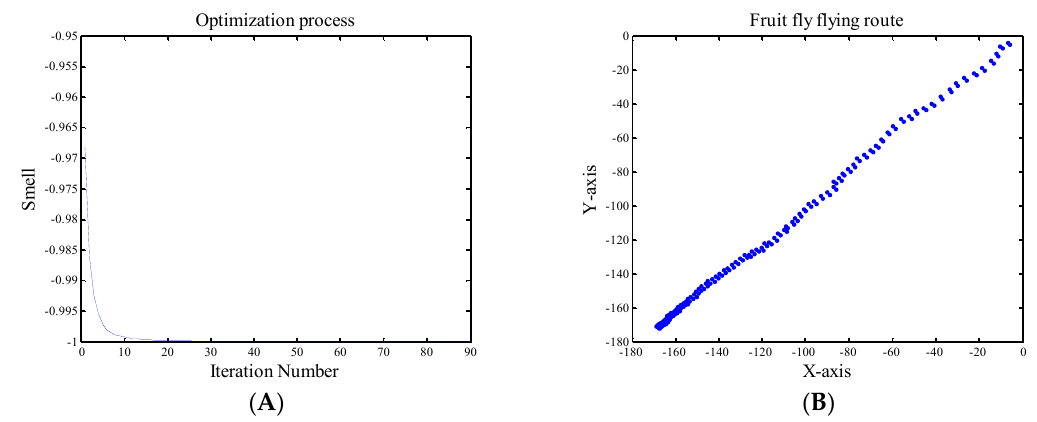
Figure 8. ( A ) Optimization process of FOA1; and ( B ) fruit fly flying route of FOA1.